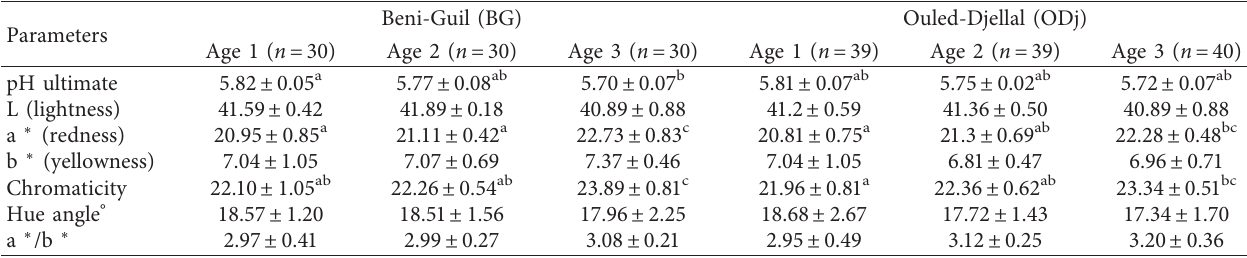
Table 2: Effect of breed and animal’s age at slaughter on ultimate pH and meat colour of Beni-Guil and Ouled-Djellal sheep breeds from eastern Morocco (means ±